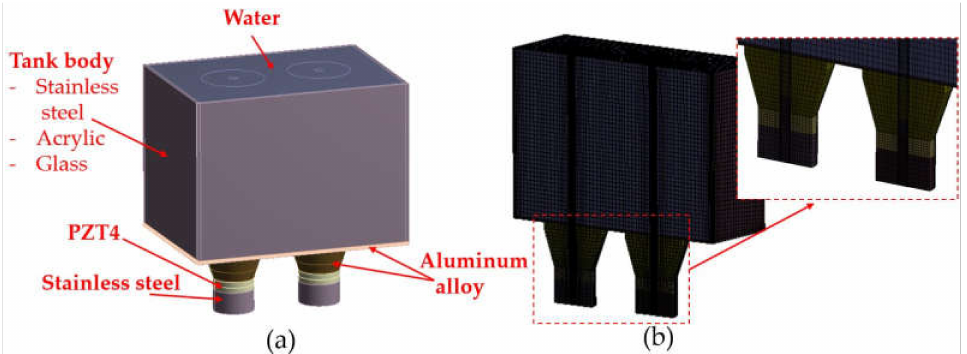
Figure 7. Models: ( a ) a simplified CAD model and ( b ) a mesh